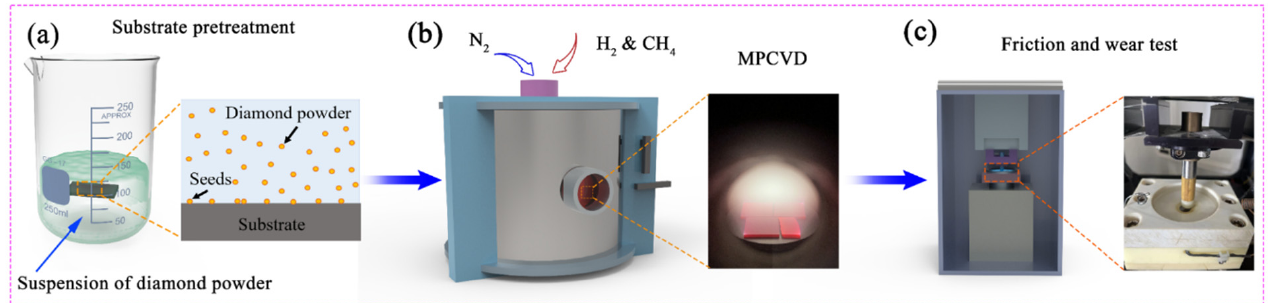
Figure 1. ( a ) Pretreatment of the substrate; ( b ) Preparation of diamond coating; ( c ) Testing of tribological properties.